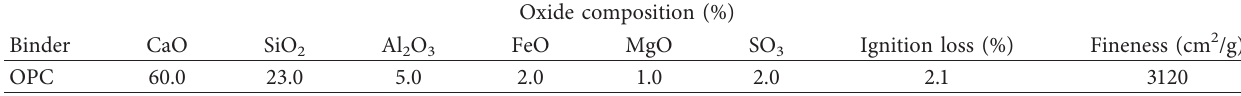
Table 1: Oxide composition of ordinary Portland cement used for the experimental